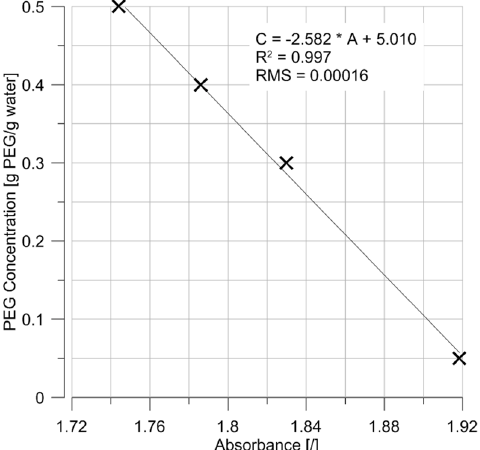
Figure 9. Preliminary calibration curve of the immersible sensor for PEG concentration measurement.